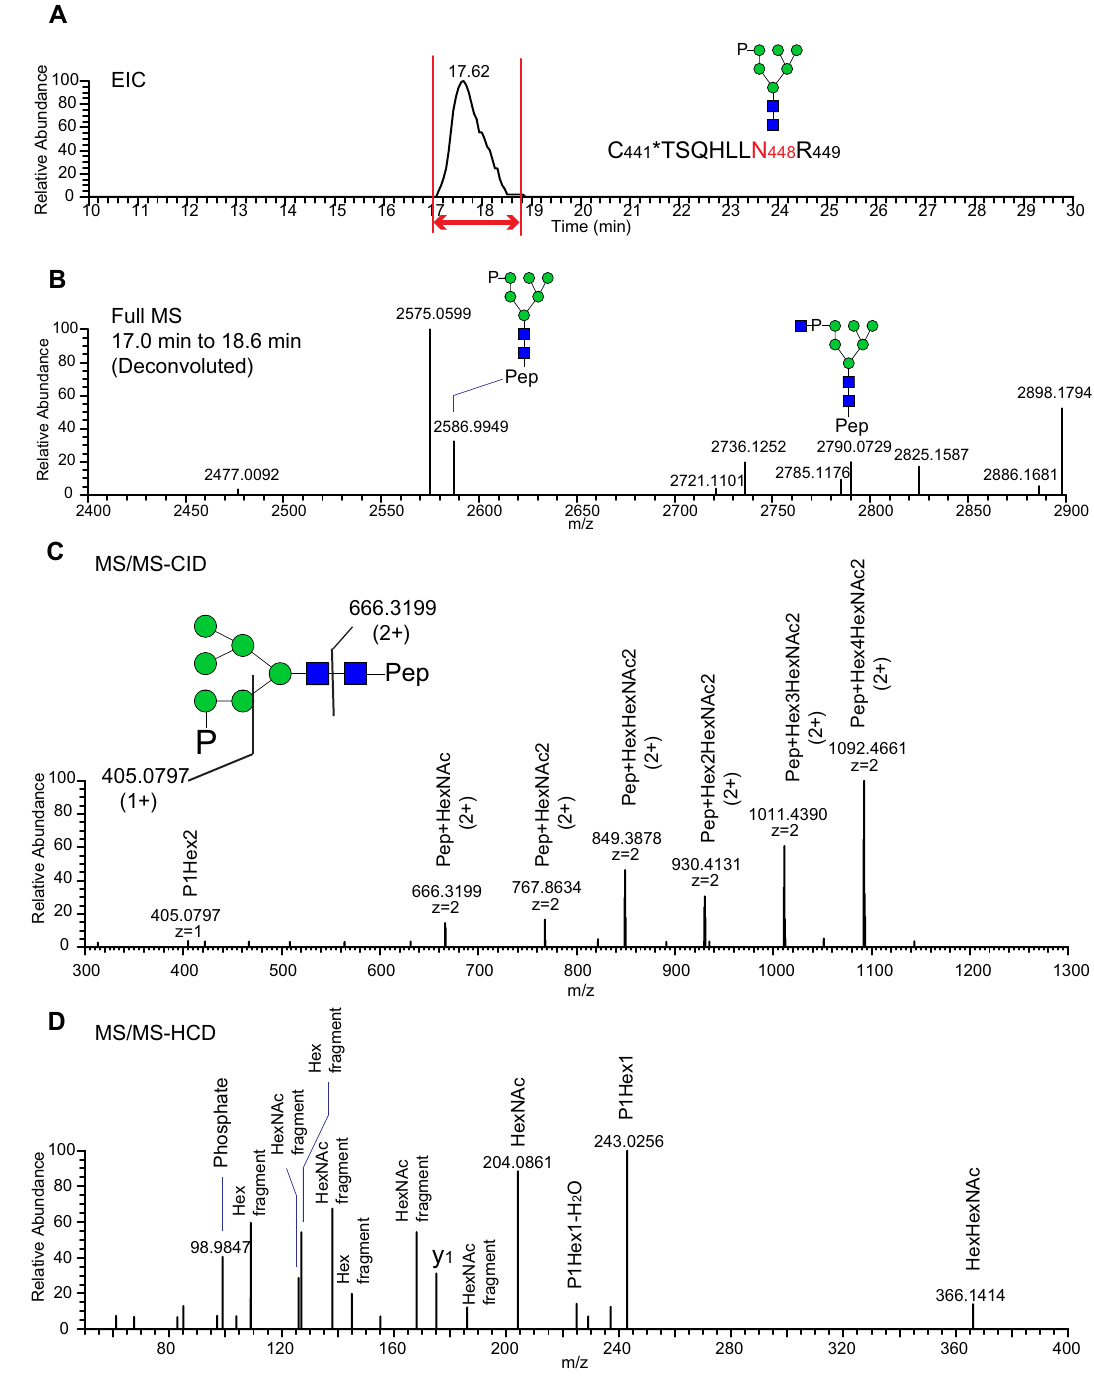
Figure 8. M6P is detected at tPA N448. ( A ) Extracted ion chromatogram of native tPA N448 glycopeptide carrying phosphorylated, high mannose glycoform (P1M6N2). ( B ) Deconvoluted, time-averaged full mass spectrum of glycopeptides eluting between 17 to 18.6 min. ( C ) Tandem mass spectrum (MS/MS) collision- induced dissociation of glycopeptide showing series of neutral losses indicating high-mannose type glycan structure as well as fragment ion at m/z 405. 0797, corresponding to a P1Hex2 fragment. ( D ) MS/MS higher collision energy dissociation (HCD) of glycopeptide in ( C ) reveals fragment ions for phosphate (m/z 98.9847) and P1Hex1 (m/z